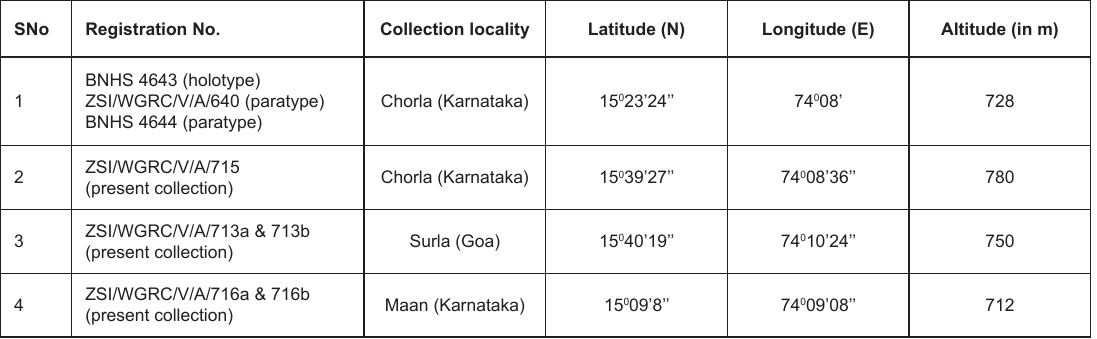
Table 2. Collection localities for G. mhadeiensis bordering Karnataka and Goa